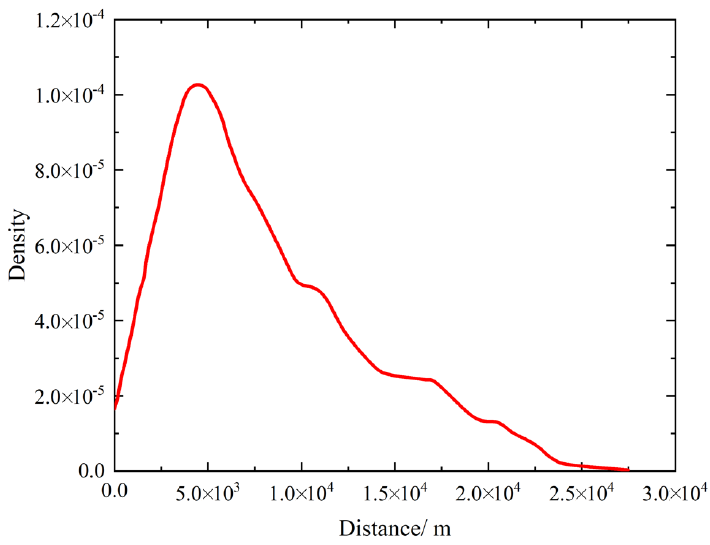
Figure 13. Kernel density estimation